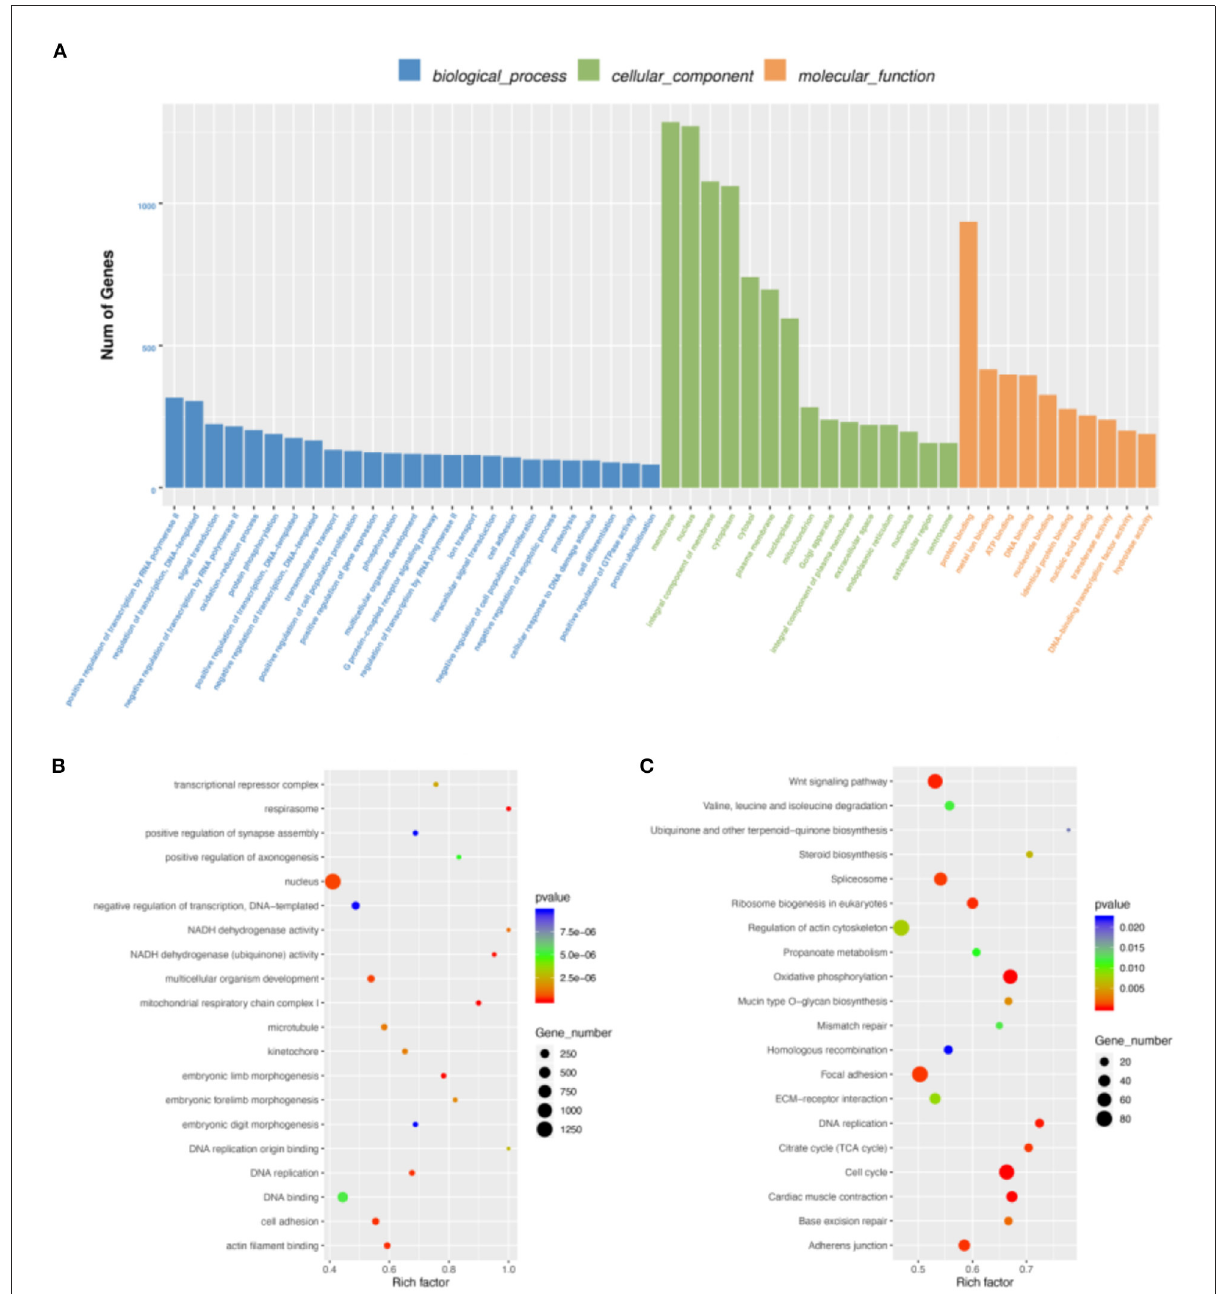
FIGURE3 Differentially expressed gene (DEG) analysis. (A) GO enrichment barplot of DEGs. (B) GO enrichment scatterplot of DEGs. (C) KEGG enrichment scatterplot of DEGs.